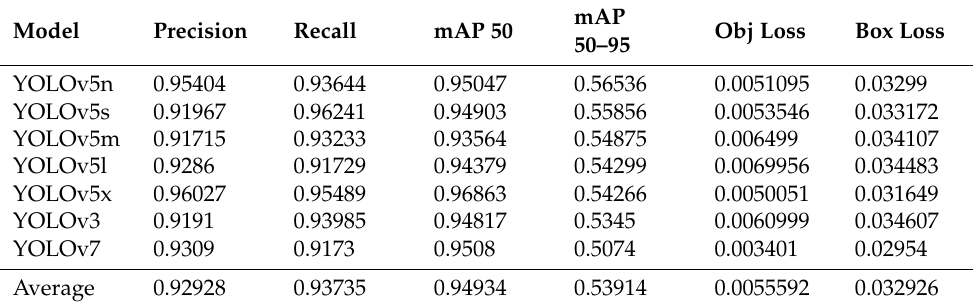
Table 5. YOLO models performance and detection accuracy